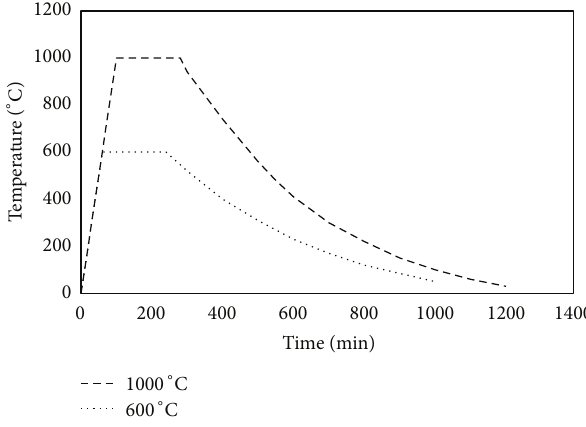
Figure 1: Temperature loading